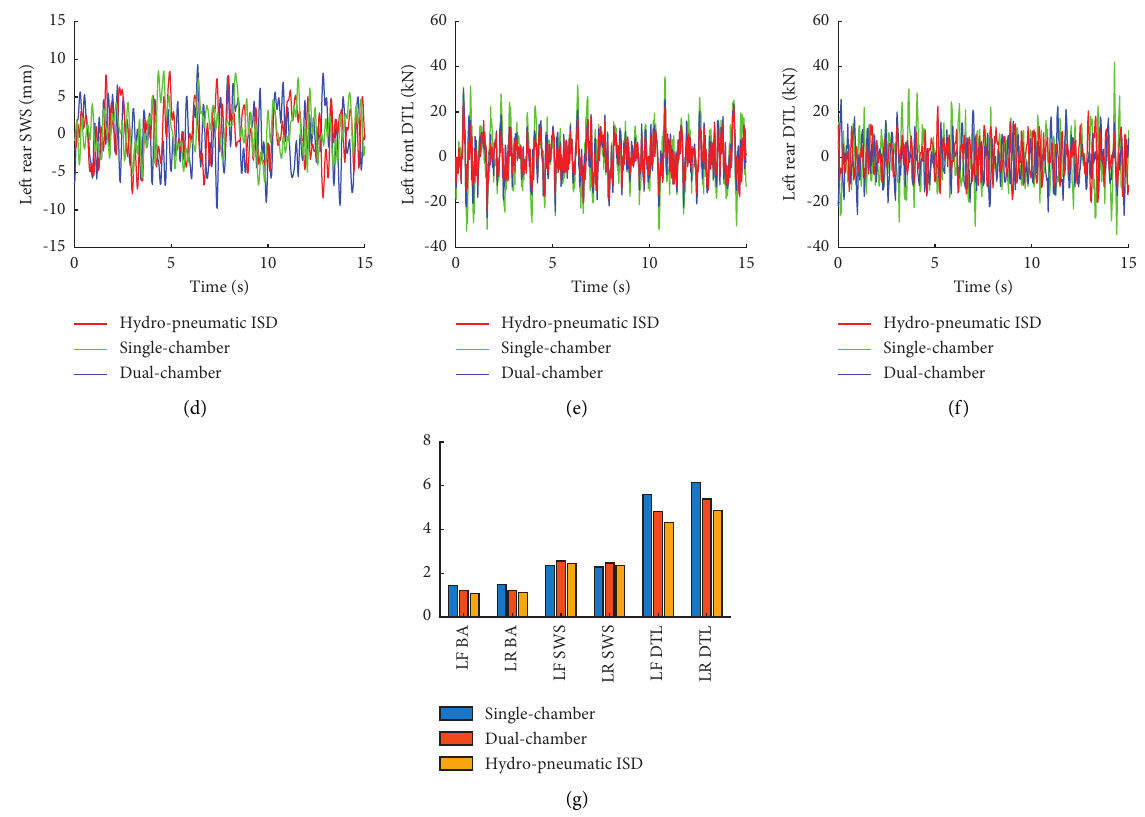
Figure 8: Comparison of random input response for simulation.